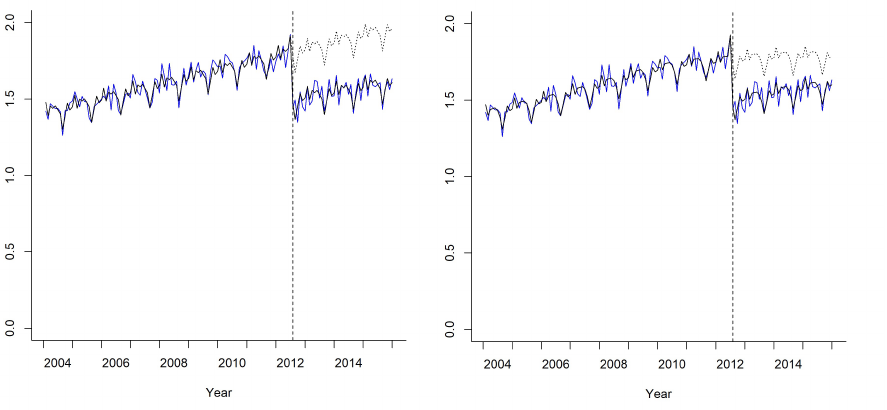
Figure 4. Results for real data. The left plot shows the segmented linear regression analysis and the right plot shows the generalized additive analysis. In both pictures, the blue line refers to the simulated data, the black line refers to the fitted values and the dashed line refers to the projection of the pre-intervention model in the post-intervention